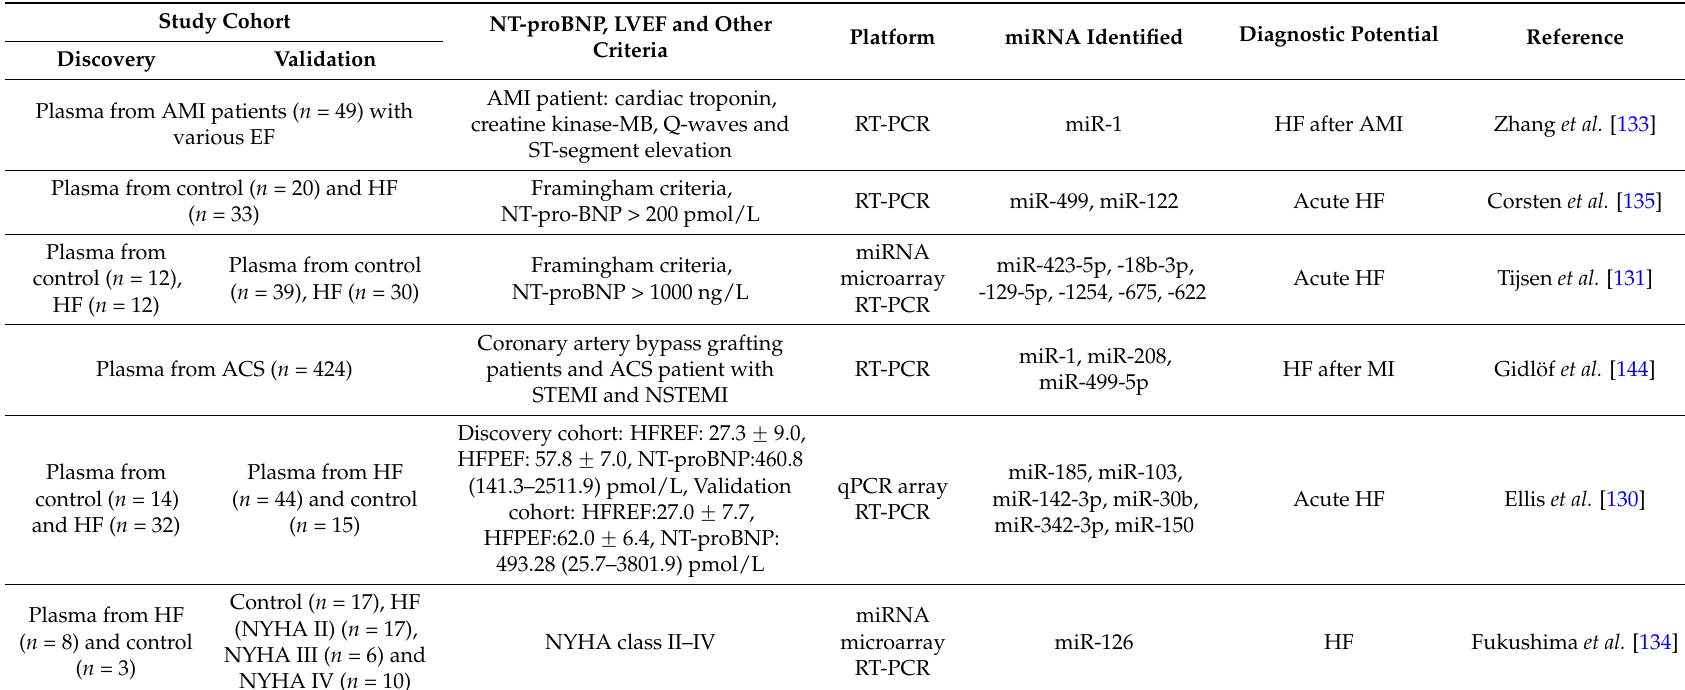
Table 6. Summary of reported miRNAs as HF biomarkers in plasma